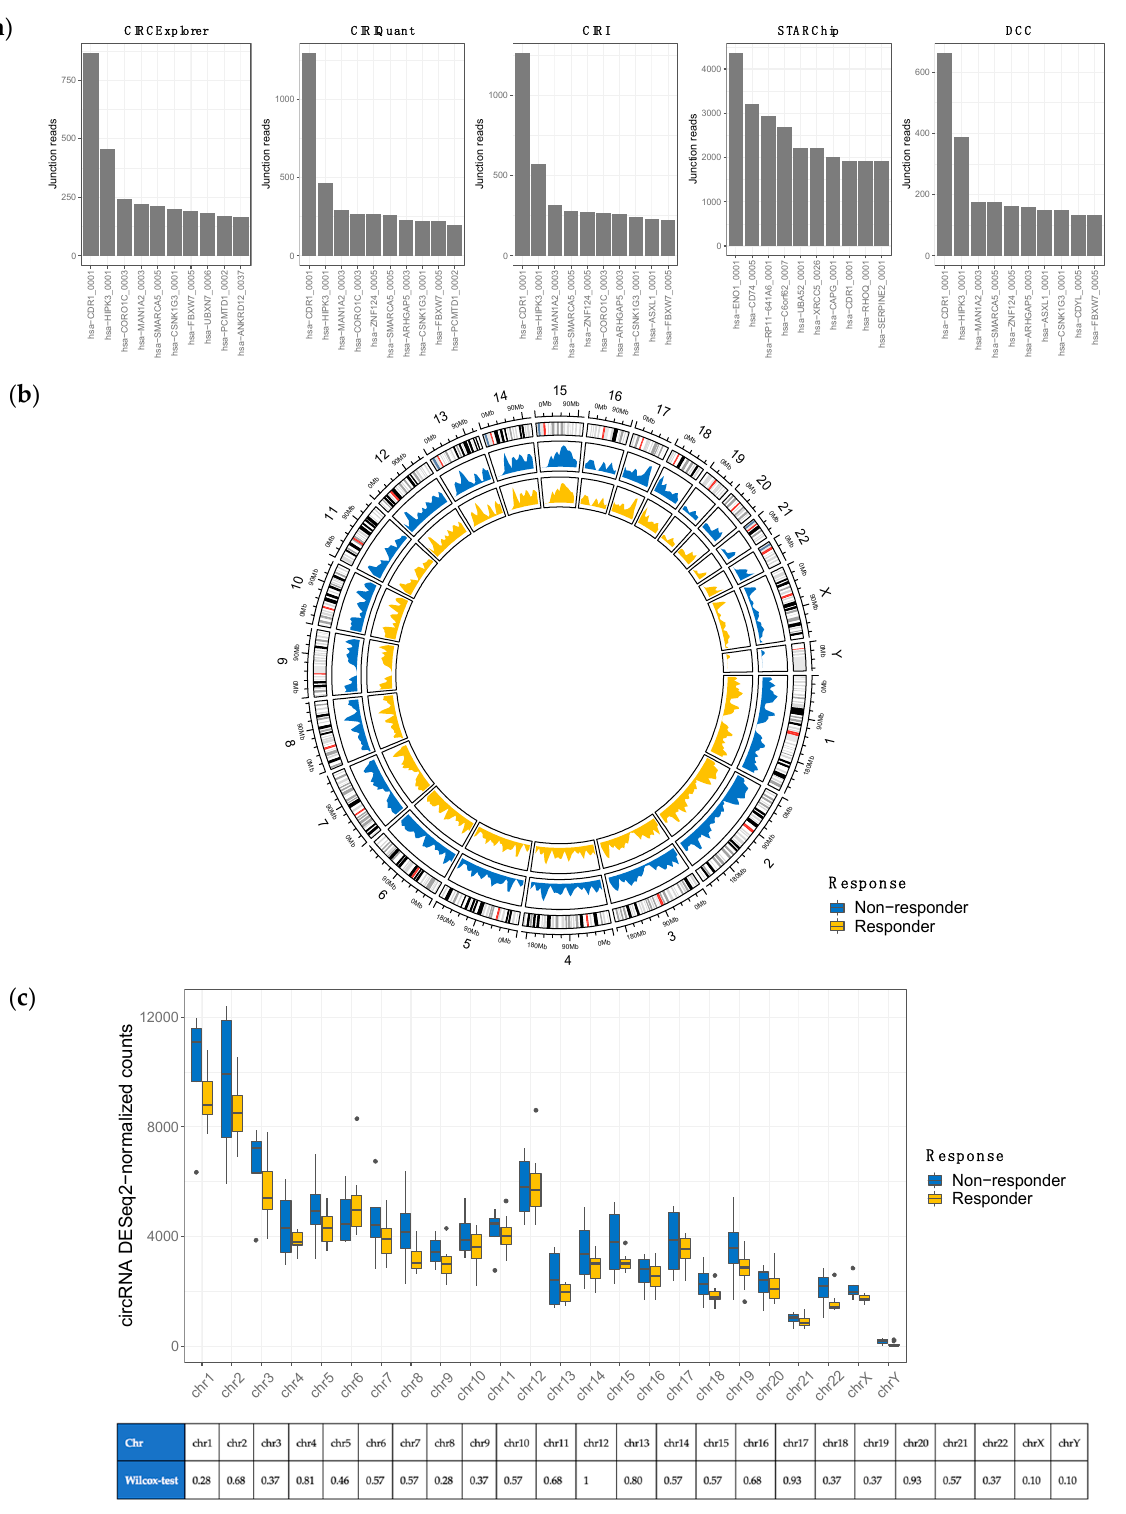
Figure 2. Frequencies and distribution of the circRNAs by response to ICB. ( a ) Top 10 circRNAs loci identified by the different algorithms used. ( b ) Horizontal chromosomal coverage. ( c ) Normalized count quantification per chromosome.